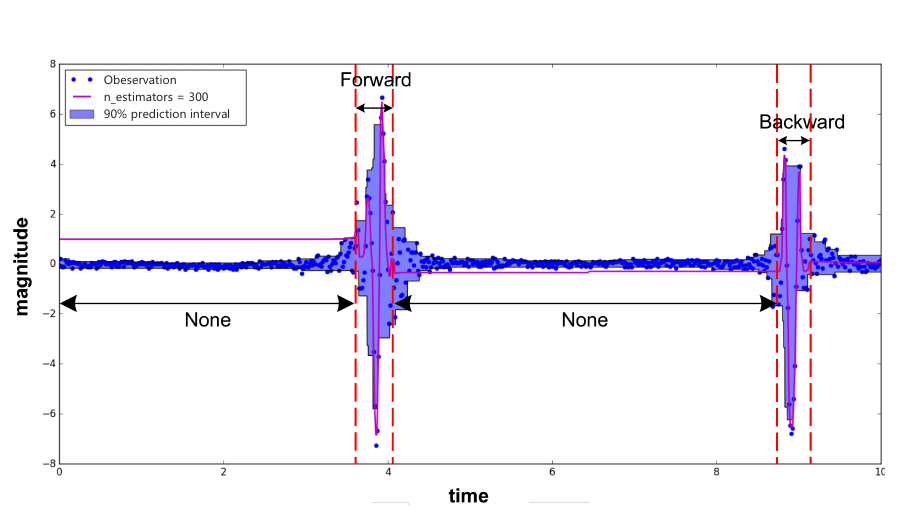
Figure 9. Boosted decision tree regression